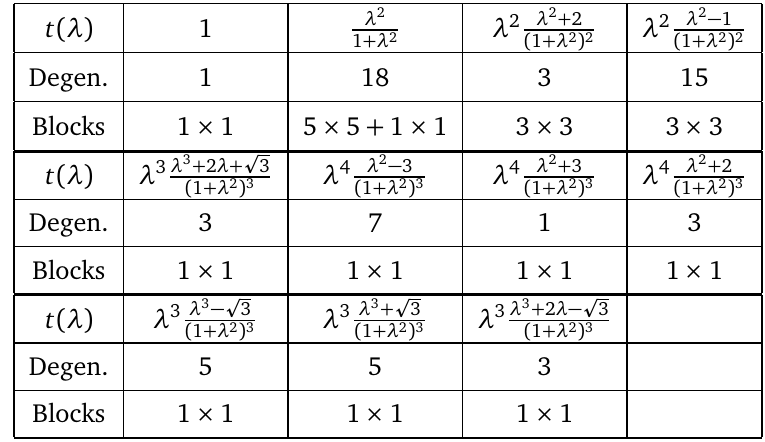
( λ ) . We find 11 different eigenvalues t ( λ ) with Table 1: Jordan Decomposition of τ 3 degeneracies and Jordan block dimensions given above. For instance, the λ 2 / ( 1 + λ 2 ) eigenvalue is 18-fold degenerate and splits into three 5 × 5 and three 1 × 1 Jordan blocks for all finite nonzero λ